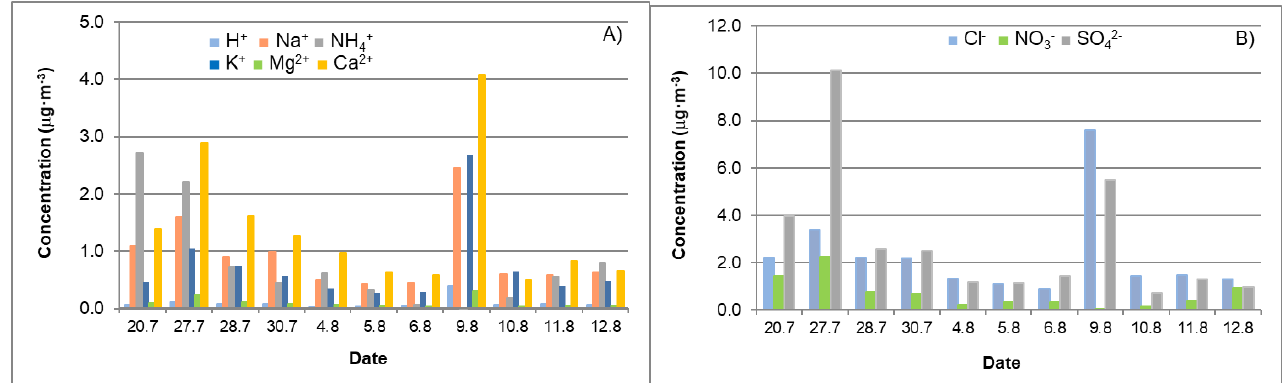
Figure 9. The distribution of the concentrations of cations ( A ) and anions ( B ) in the atmospheric aerosol at the Boyarsky research station in the summer of 2020, µ g/m 3 .